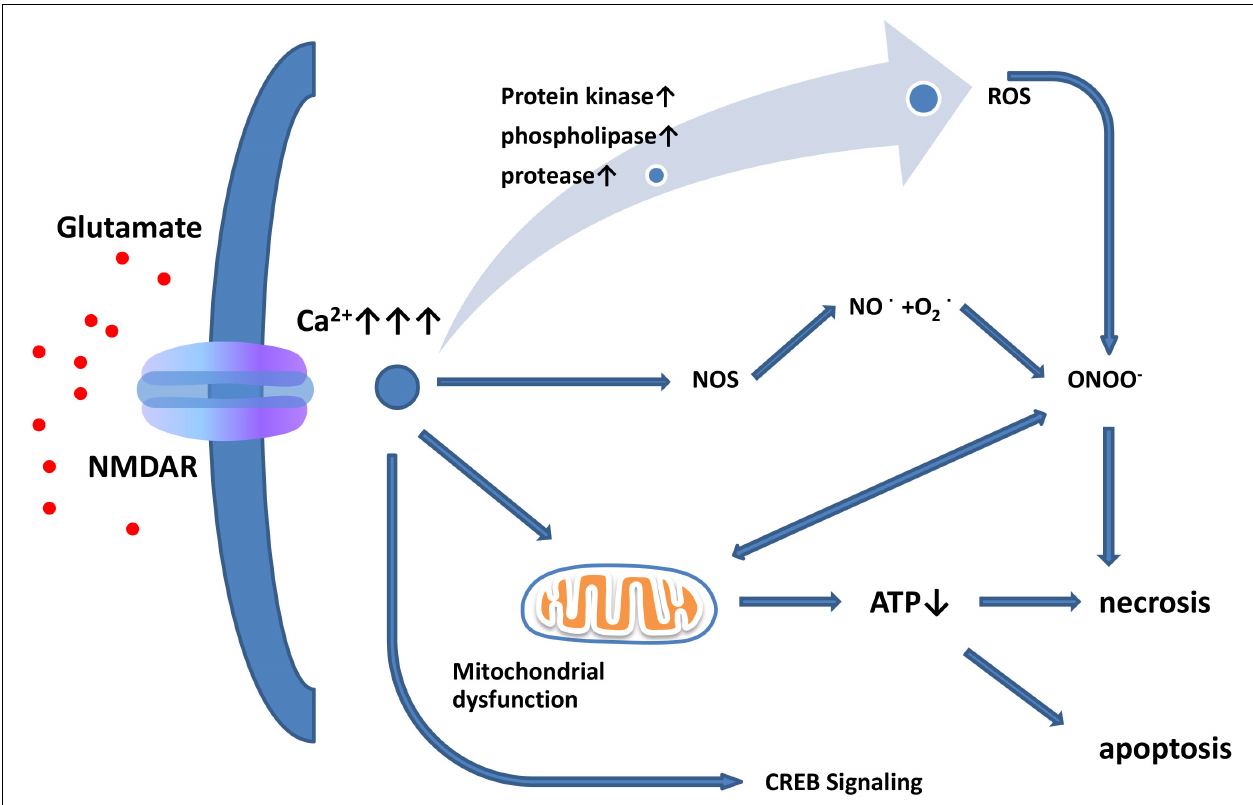
FIGURE 1 | Glutamate excitotoxicity leads to neuronal necrosis and apoptosis. Increased extracellular glutamate levels lead to overactivation of NMDARs and induce Ca 2 + influx. Ca 2 + influx increases nitric oxide synthase (NOS) activity. Through this enzyme, NO can react with superoxide radicals to generate ONOO–, thus causing serious oxidative damage to cellular contents. In addition, mitochondria are damaged by oxidation, leading to ATP depletion and cellular death. Excessive activation of extrasynaptic NMDARs leads to reduced CREB signaling, resulting in mitochondrial membrane-potential loss and cell death, while synaptic NMDARs affect the CREB pathway but do not induce